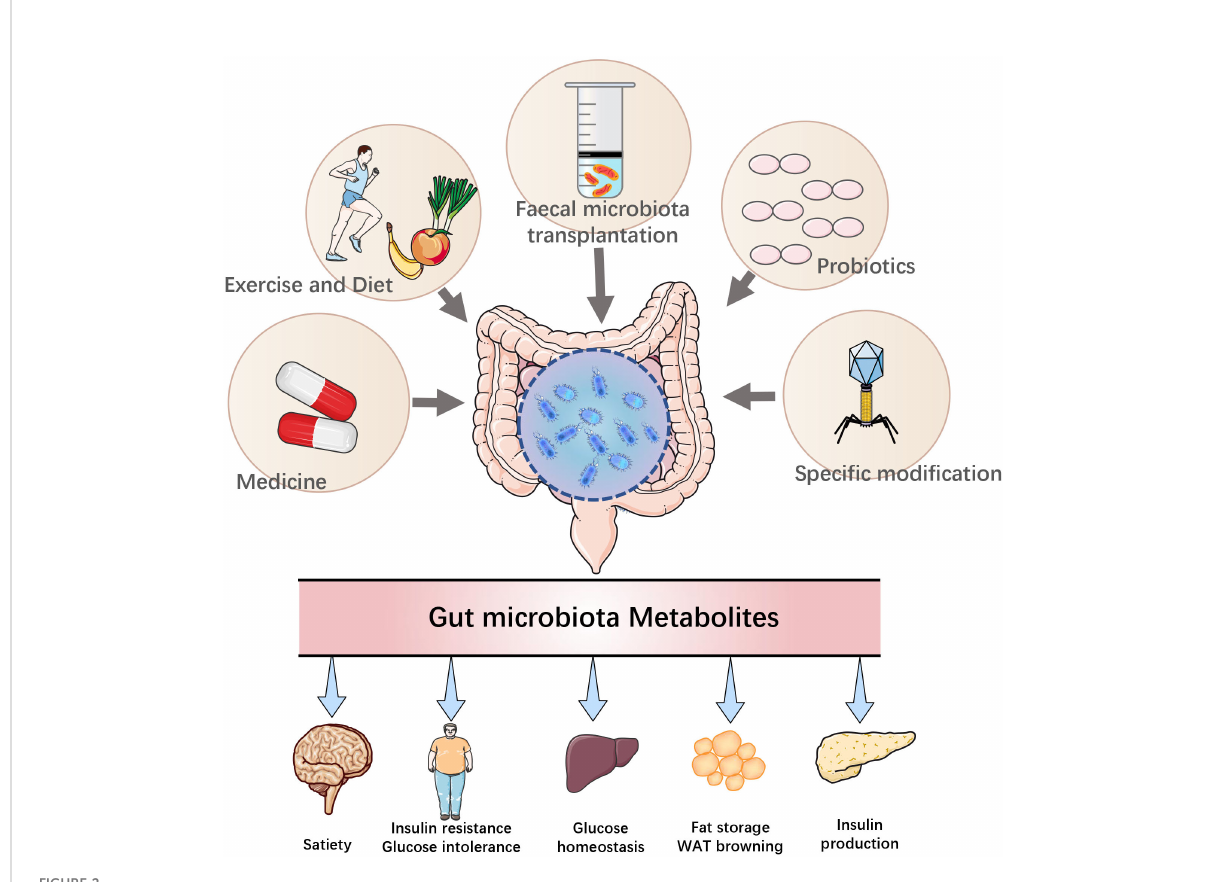
FIGURE 2 Modulation of T2DM by therapeutic approaches targeting the gut